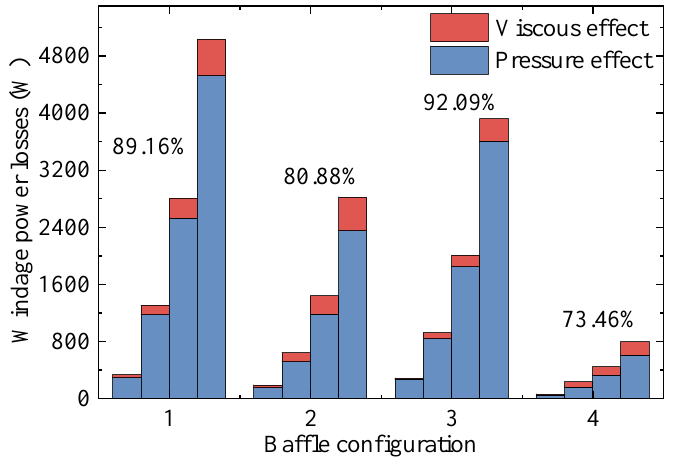
Figure 12. Proportion of the pressure and the viscous effect in different baffle configurations.